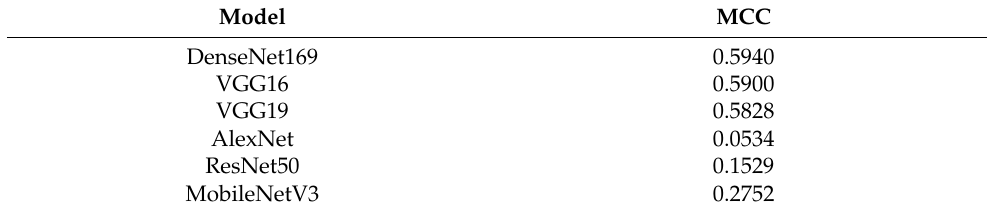
Table 8. MCC performance results of the deployed pretrained DL models.